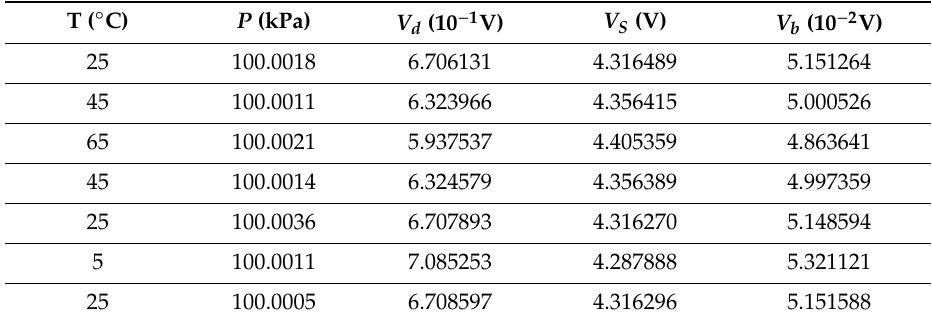
Table 2. Raw data collected at a nominal pressure of 100 kPa absolute for a typical L1-F sample when subjected to the first 5 to 65 °C cycle.